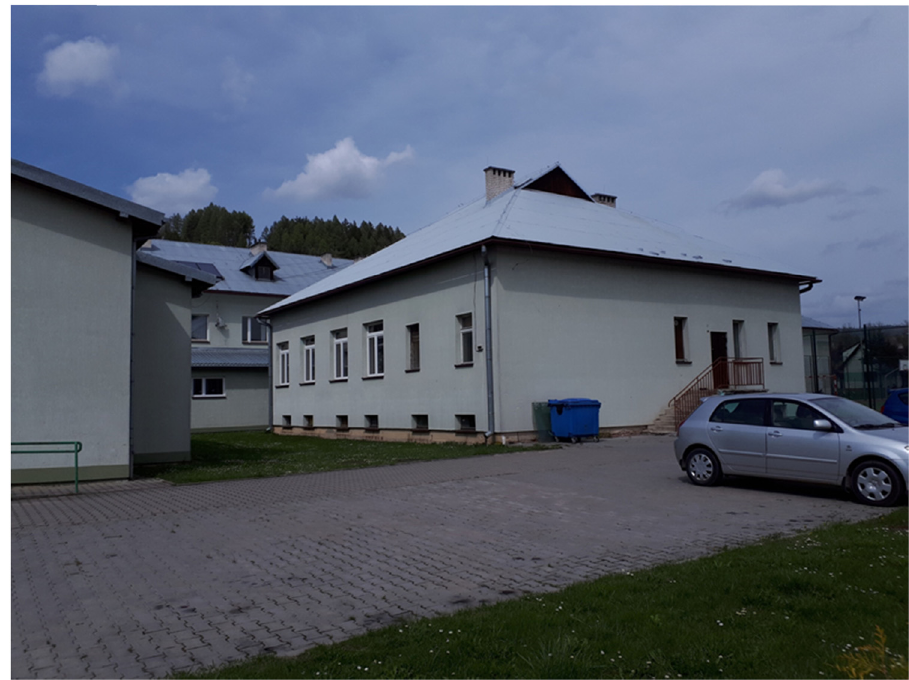
Figure 3: Elementary school in Powro ź nik ( source: Tomasz Sumera ) .